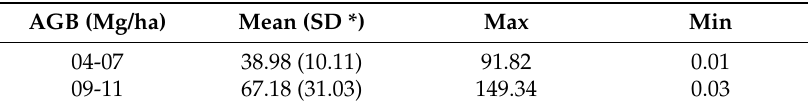
Table 6. Aboveground biomass estimation